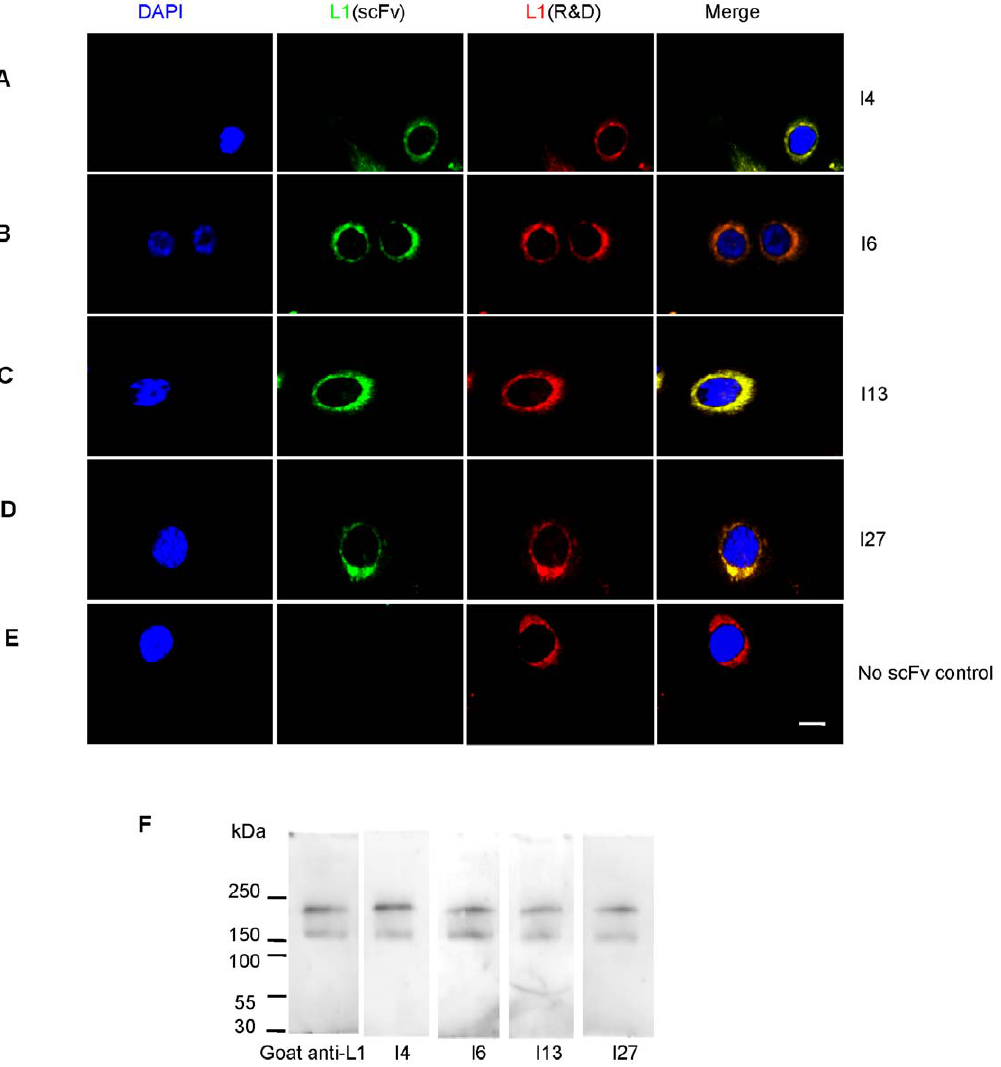
Figure 3. Immunostaining of live SK-N-SH cells with ScFvs. Substrate-attached SK-N-SH cells were incubated with scFvs I4 ( A ), I6 ( B ), I13 ( C ), or I27 ( D ), or without scFv ( E ). Bound scFvs were visualized by rabbit antibody against the His-tag followed by incubation with Alexa 488 nm (green)- conjugated goat anti-rabbit IgG and double labeling with goat anti-human extracellular domain of L1 as positive control, followed by Alexa 594 nm (red)-conjugated donkey anti-goat IgG. Bar in ( E ) indicates 5 m m for all panels. ( F ) Binding of purified scFvs I4, I6, I13, I27 to an SK-N-SH cell lysate was tested by subjecting 50 m g protein to SDS-PAGE in 8% gels under reducing conditions. Western blot analysis was carried out with scFvs I4, I6, I13, I27, and goat anti-human L1 as primary antibodies. Primary antibodies were detected with secondary antibody against His or rabbit anti-goat, respectively. Molecular weight markers are indicated at the left margins in kilodaltons (kDa).